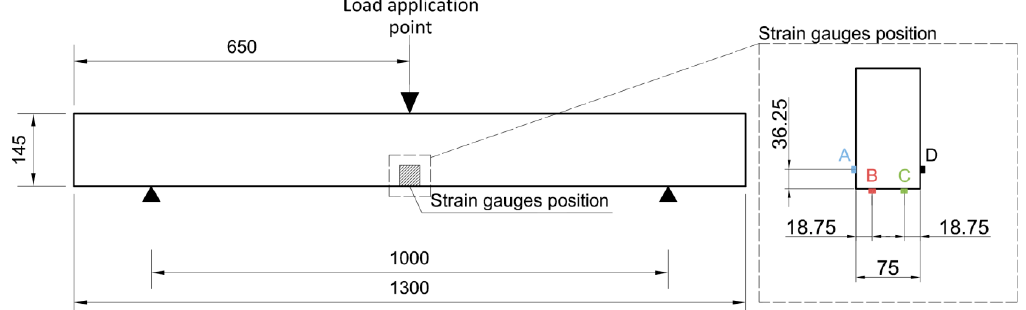
Figure 3. Schematic representation of the 3-point bending test and location of the strain gauges at the beam faces (distances in mm).